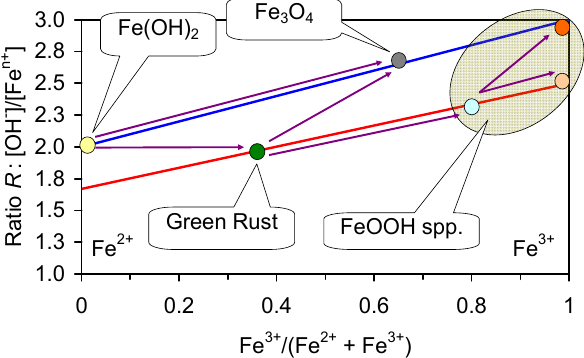
Figure 24. Relationship between Ratio R , and Fe 3+ content surrounding ZVI and the